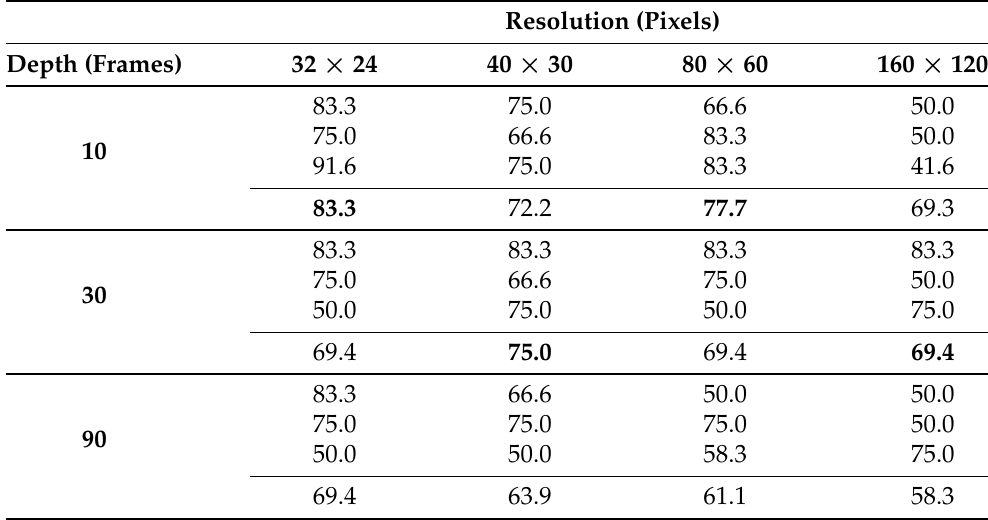
Table 2. Accuracy (%) of the models trained with the 12 different configurations from experiment P01. Each cell presents the accuracy of three independent models per configuration and its average. The best results per resolution are highlighted in bold.